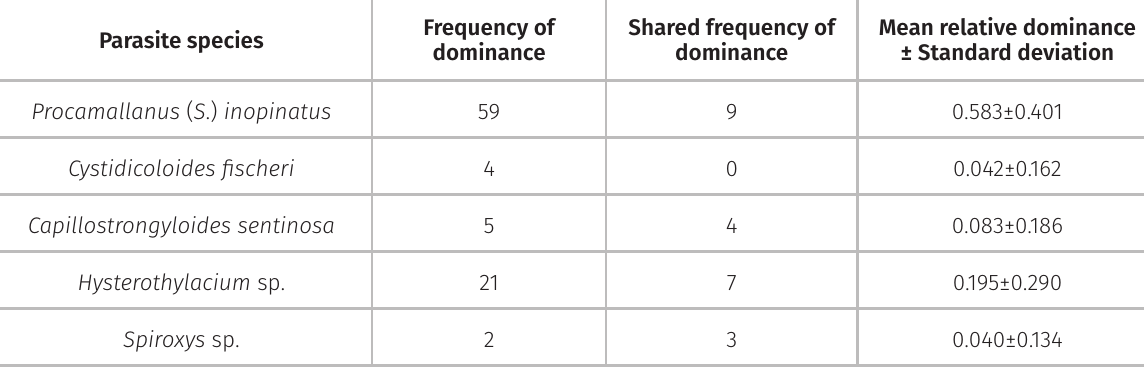
Table II. Frequency of dominance, shared frequency of dominance, and mean relative dominance of the metazoan endoparasites of Pygocentrus piraya from Três Marias reservoir, upper São Francisco river, state of Minas Gerais, Brazil.